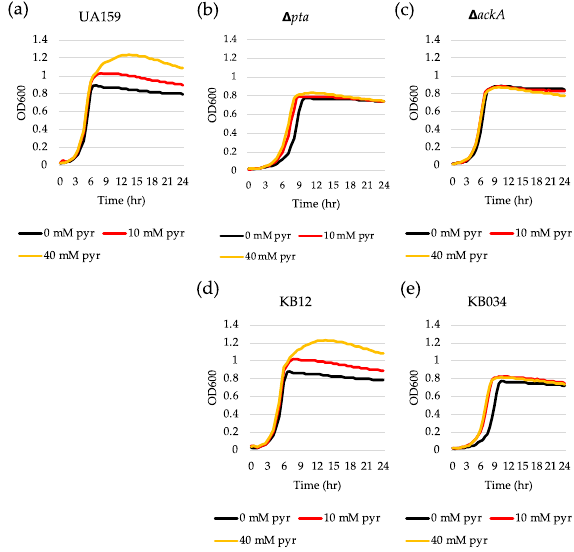
Figure 7. The effect of exogenously added pyruvate on the stationary phase of growth of S. mutans UA159 wild type and Pta-AckA pathway derivative strains. Wild type ( a ), ∆ pta ( b ), ∆ ackA ( c ), KB12 ( pta -complemented, ( d ) and KB034 ( ackA -complemented, ( e ) strains were grown in BHI, supplemented by different concentrations of pyruvate (0, 10 and 40 mM). Optical density at 600 nm was monitored every 30 min at 37 °C using the Bioscreen C lab system. The results are representative of three independent experiments.